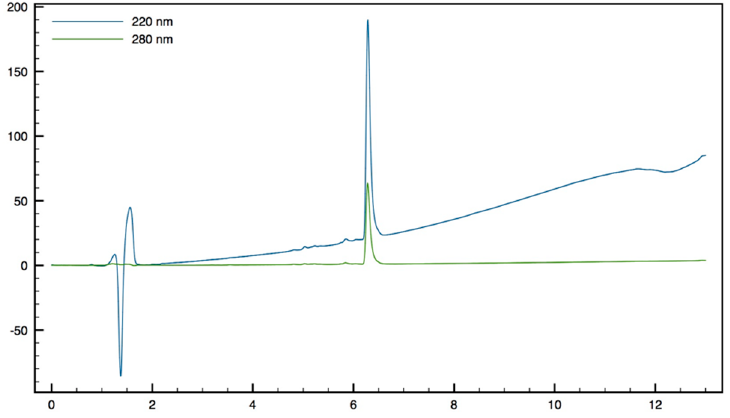
Figure 18. HPLC profile of Fmoc-Tbt - β 2,2 - h -bis-Orn-OMe 17a Figure 18 . HPLC profile of Fmoc-Tbt- β 2,2 -h-bis-Orn-OMe 17a .